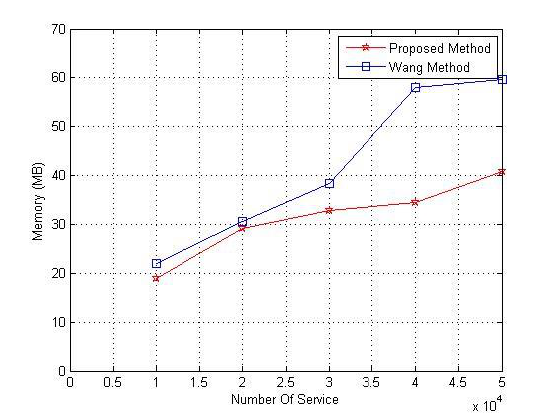
Figure 7. Comparison of memory usage per composition